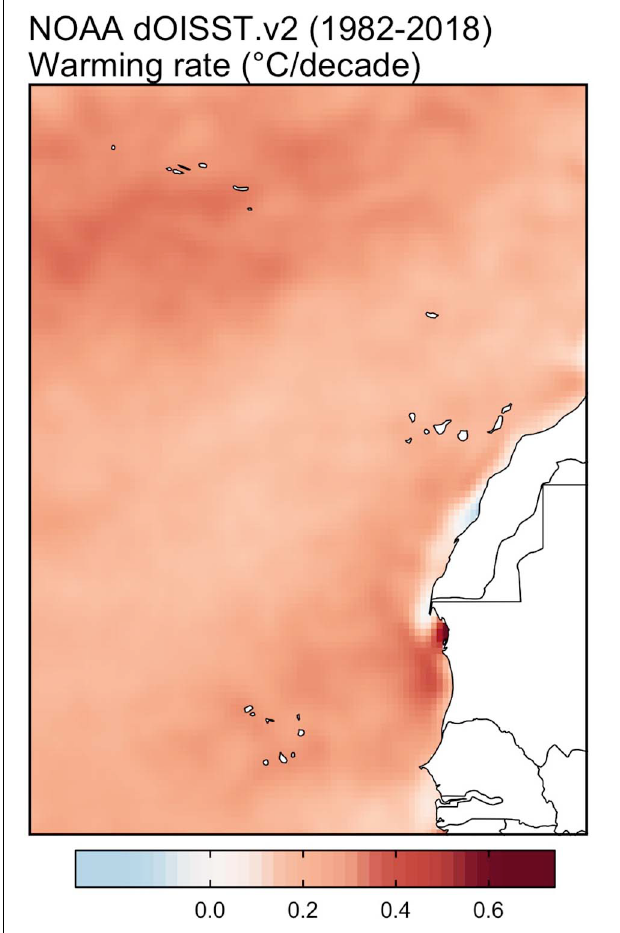
FIGURE 3 | Rates of sea surface warming in NE Atlantic archipelagos, based on 37 year of daily sea surface temperatures (SSTs; 1982–2018) from National Oceanic and Atmospheric Administration (NOAA) 1/4 arc-degree Daily